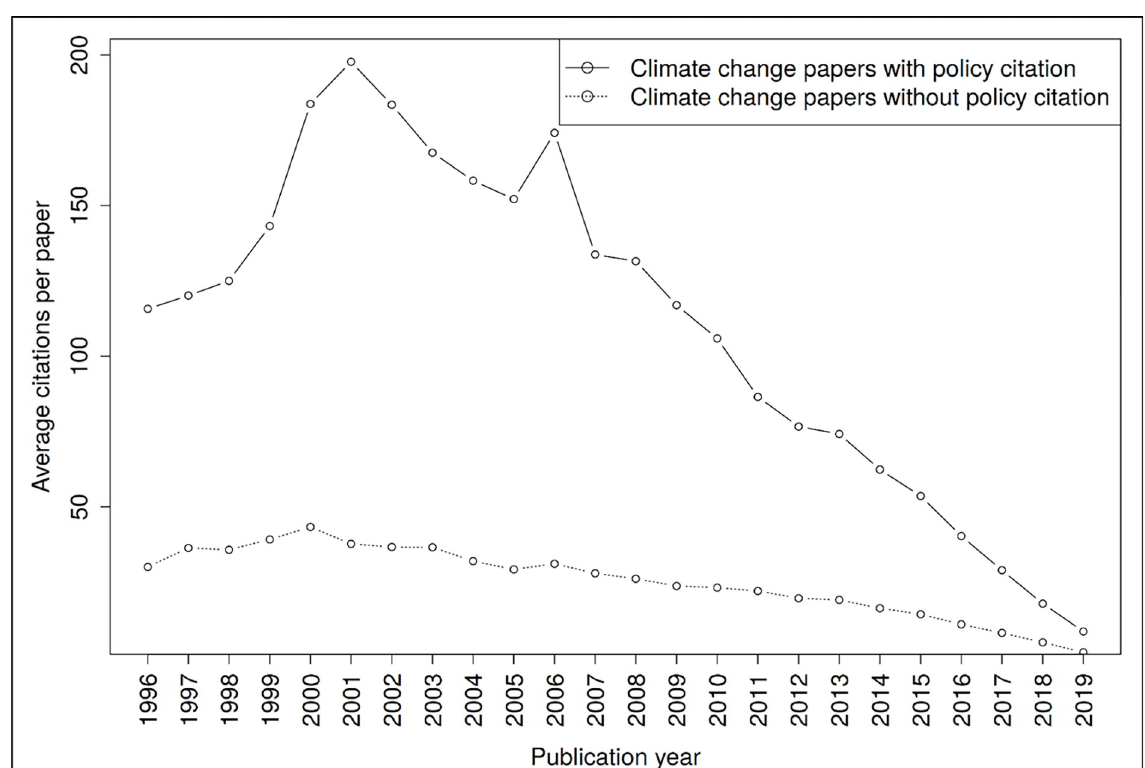
Fig 8. Average citations per paper of climate change papers in the scientific literature that are cited in policy documents (solid lines) or not (dotted lines).